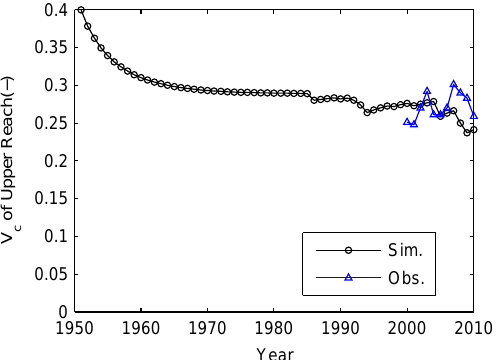
Figure 6. Vegetation cover ( V c ) of the upper reach of the Tarim River.